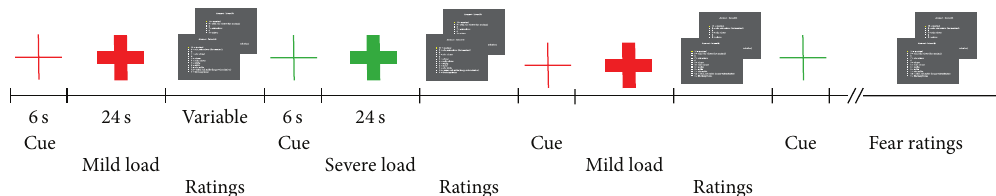
Figure 1: MRI task and protocol. In alternating order, subjects were visually cued for either mild or severe dyspnea followed by the respective load. Each load was followed by two Borg rating scales, one on dyspnea intensity and one on dyspnea unpleasantness. The order of the scales was randomized. Each anticipatory cue lasted for 6s. Then the cue, a thin cross, turned into a solid cross and the load was introduced manually for 24 s. There were ten blocks of mild and severe dyspnea, respectively. The last intensity and unpleasantness ratings were followed by ratings on the average anticipatory fear during the two different